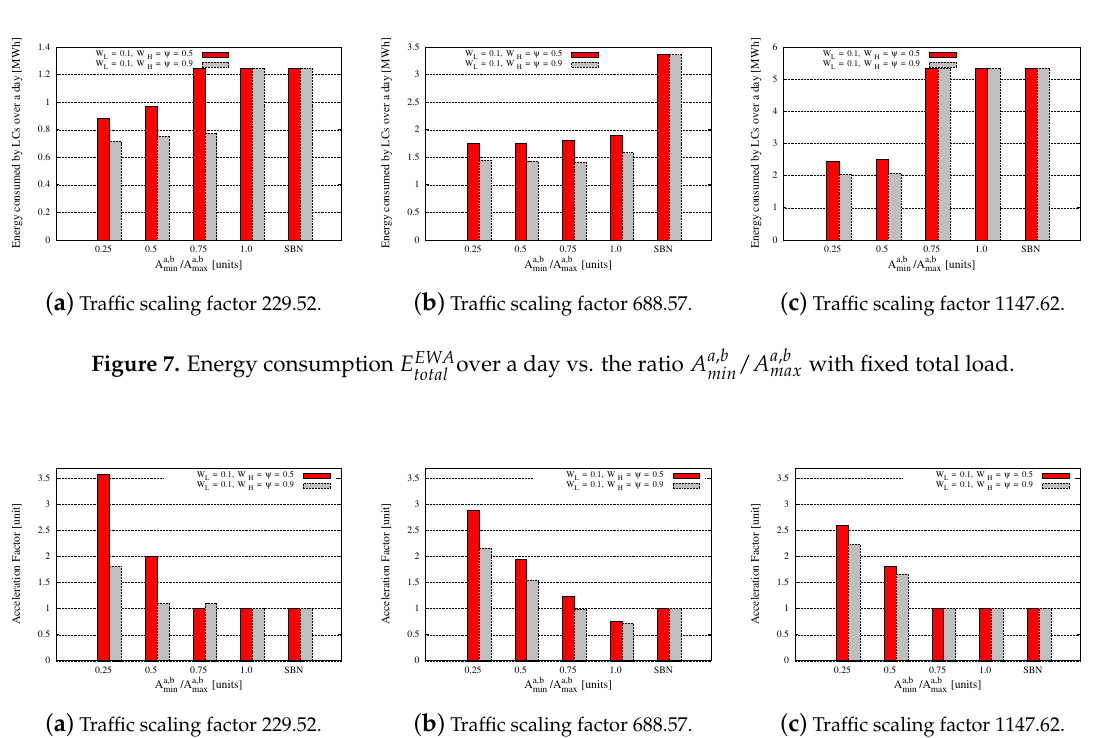
( c ) Traffic scaling factor 1147.62.